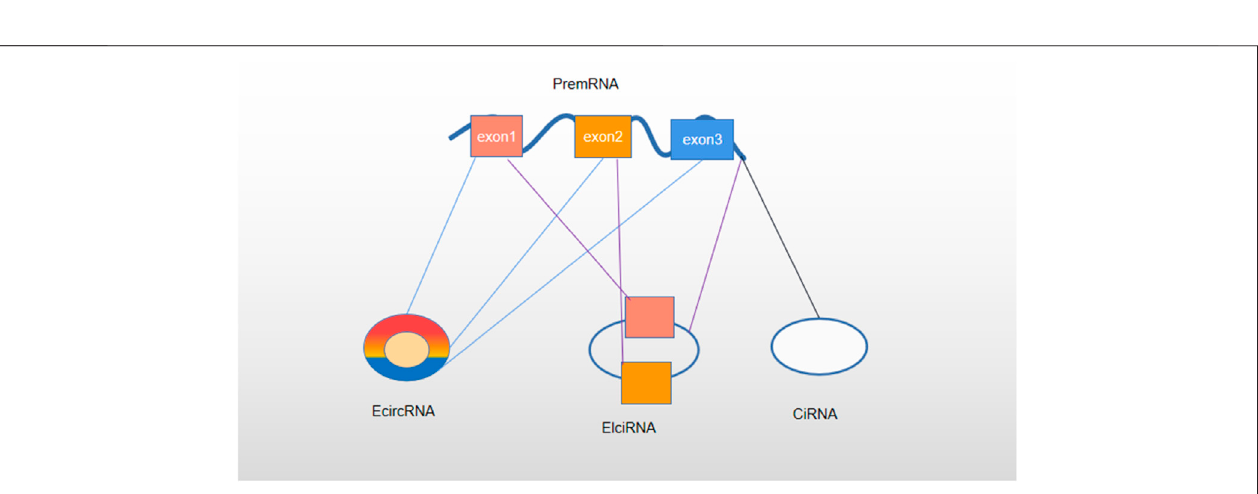
Frontiers in Pharmacology |